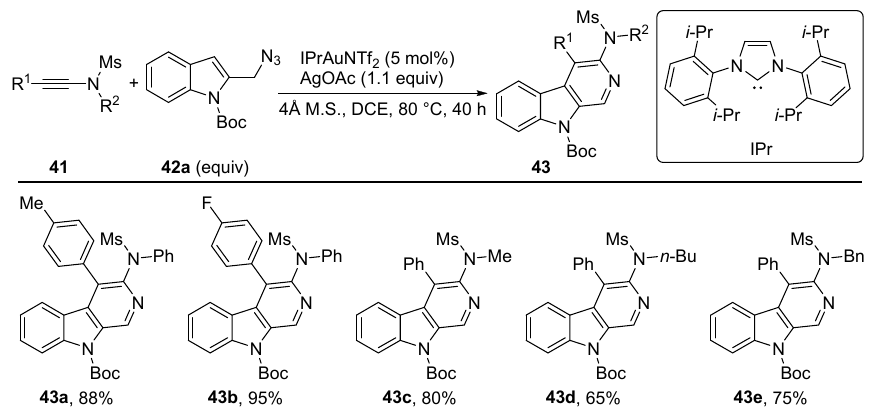
Scheme 23. Synthesis of 3-amino- β -carbolines 43 . M.S. = molecular